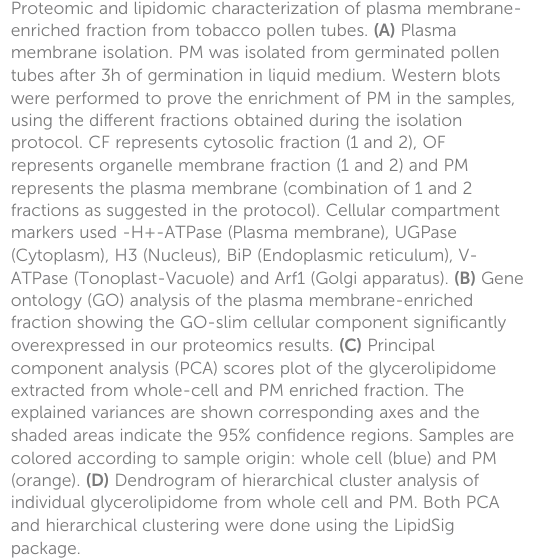
FIGURE 4 Proteomic and lipidomic characterization of plasma